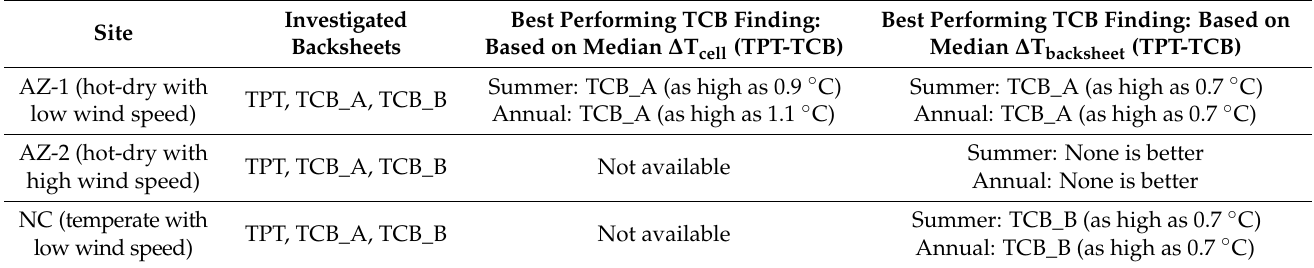
Table 6. Summary based on field thermal performance of one-cell modules at three